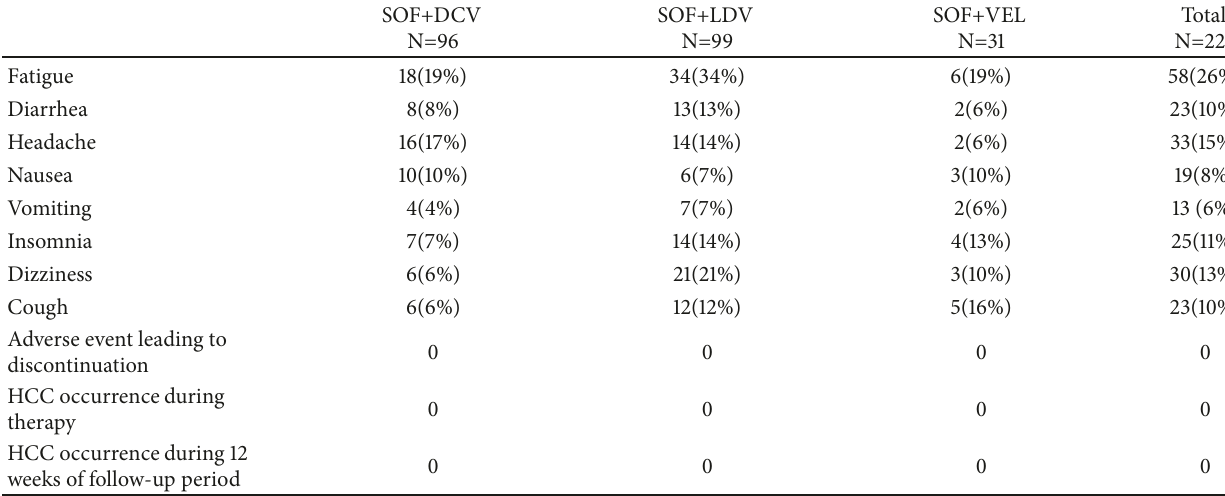
Table 4: Adverse events frequency and